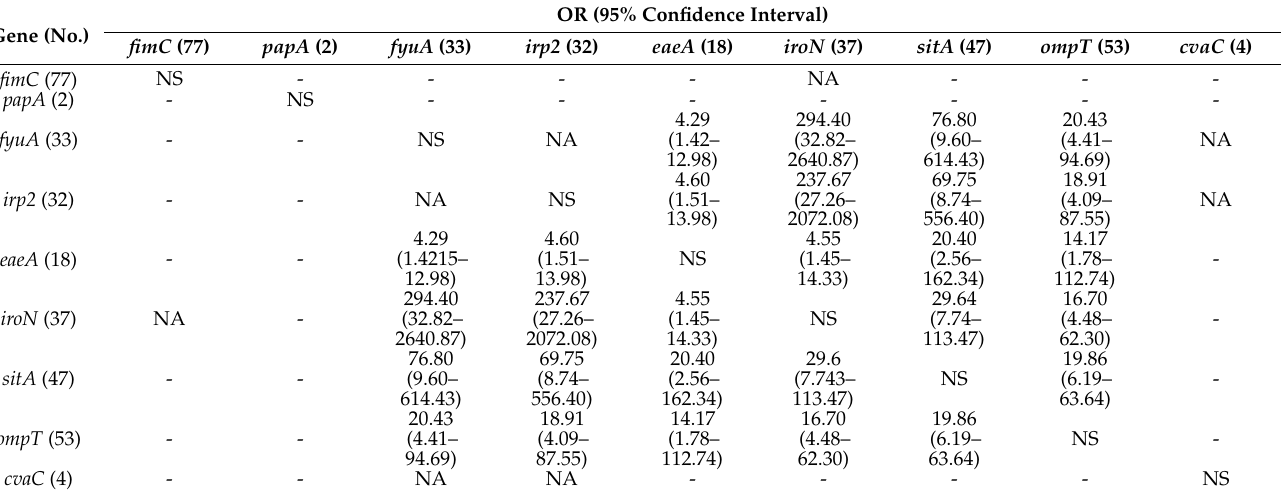
Table 4. Odds ratios (OR) of virulence-associated genes in E. coli isolates from captive giant pandas (n = 84).